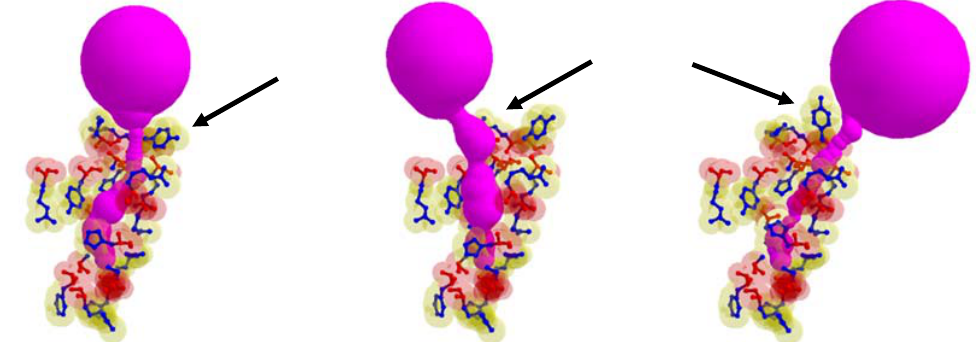
Figure 7. The case when the position of tunnel entrance is changed due to the different rotamer conformations, where arrows indicate changes of the rotamer (tunnel Id. 76 of PDB Id. 1MQF).